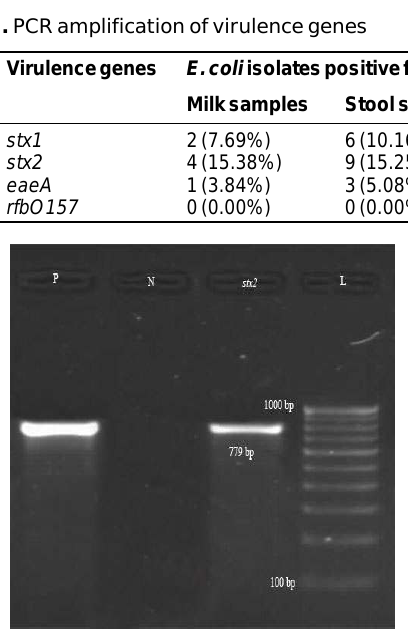
Figure-2. Agarose gel showing PCR amplified product (779 bp) for stx2 gene in E. coli isolates. P: Positive control, N: Negative control, L: DNA Ladder, stx2: Positive sample